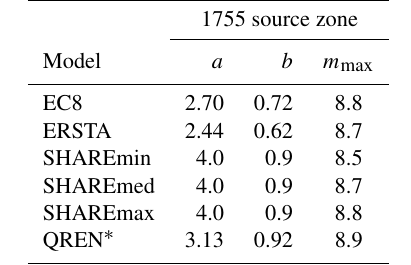
Table 3. Earthquake recurrence parameters ( a , b , m max ) for the 1755 source zone from four of the models investigated. Note that a and b are constants and m max represents the maximum magnitude.